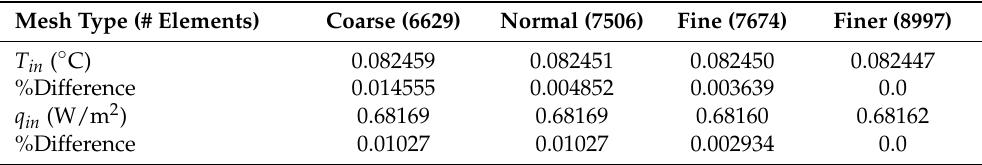
Table 2. Mesh independence analysis for the thermal bridge of intermediate floors under the stan- dard